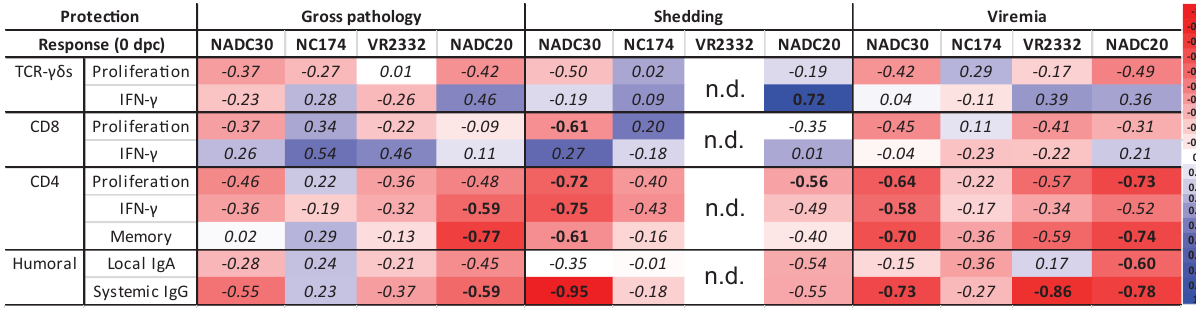
TABLE 2 Immune correlates of protection.